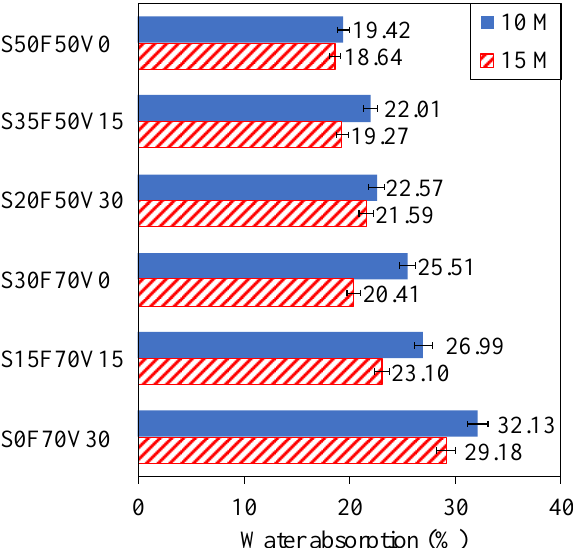
Figure 8. Water absorption of the geopolymer mortar at 28 days.